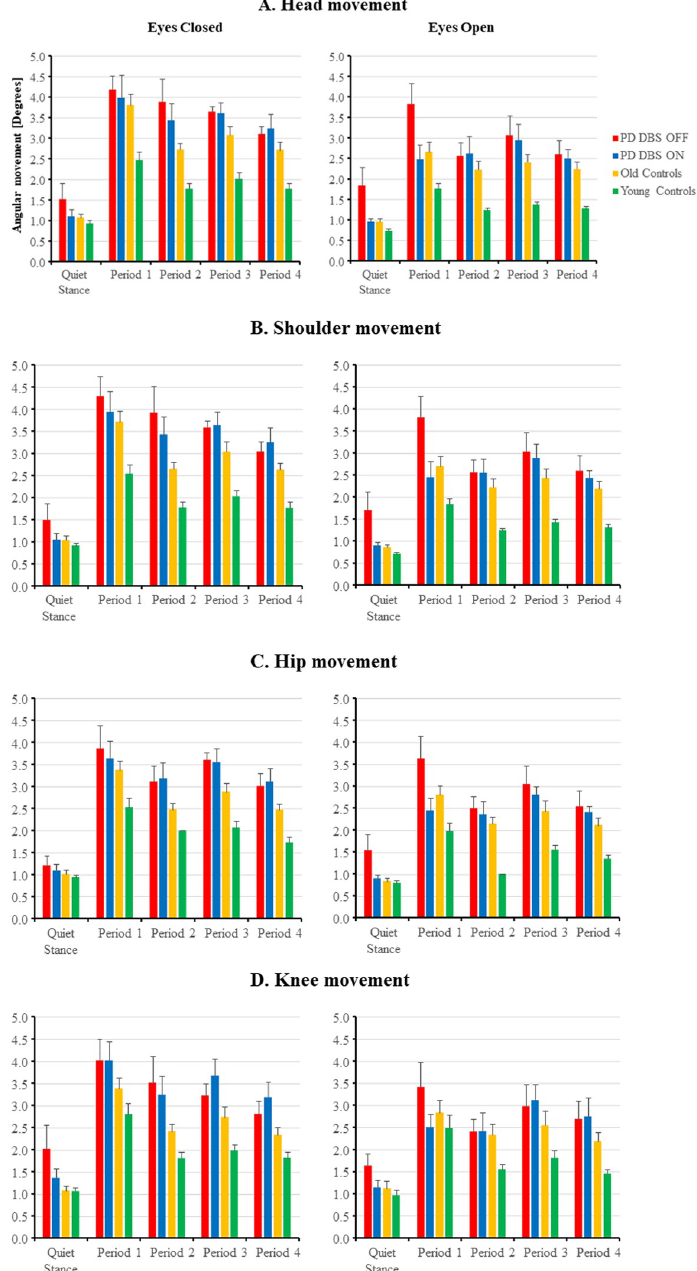
Fig 4. Body movement sizes during different phases of the posturography tests. Results are presented for tests with eyes closed and eyes open in patients with PD with DBS OFF; in patients with PD with DBS ON; in old and in young controls. Fig 4A presents the head movements, Fig 4B the shoulder movements, Fig 4C the hip movements and Fig 4D the knee movements. The values are in degrees, where the size of the bars represent group mean values and the whiskers mark the SEM values. All group categories decreased their body movements at all sites during balance perturbations, signifying a decreasing impact of the balance perturbations.